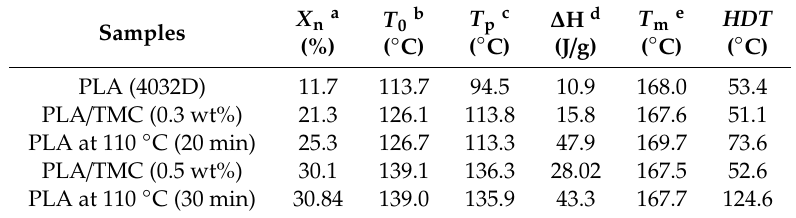
Table 2. Differential scanning calorimetric (DSC) parameters and HDT of PLA samples. Table 2. Di ff erential scanning calorimetric (DSC) parameters and HDT of PLA samples.